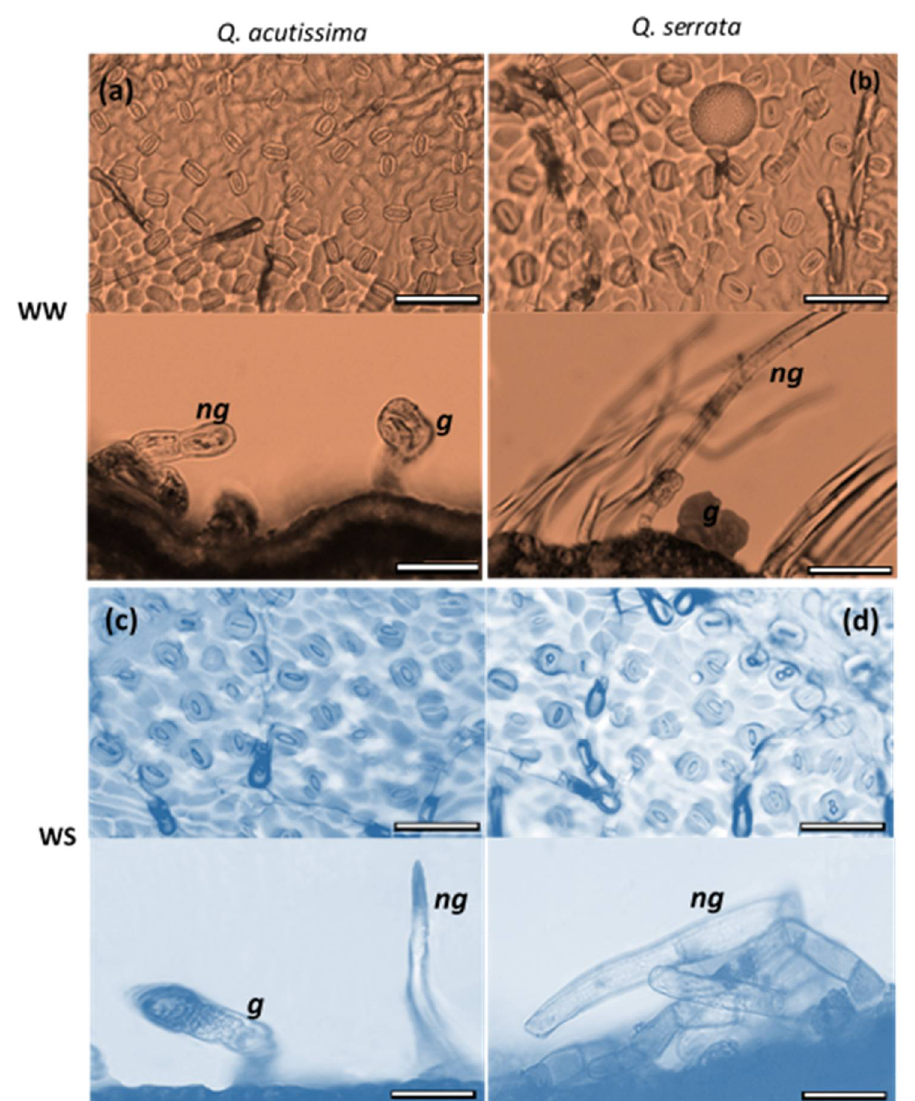
Figure 3. Glandular (g) and non-glandular trichomes (ng) of Quercus acutissima and Q. serrata in ( a , b ) well-watered (WW) and ( c , d ) water-deficit stress (WS) treatments at the final week. The bar represents 59. 5 µm.